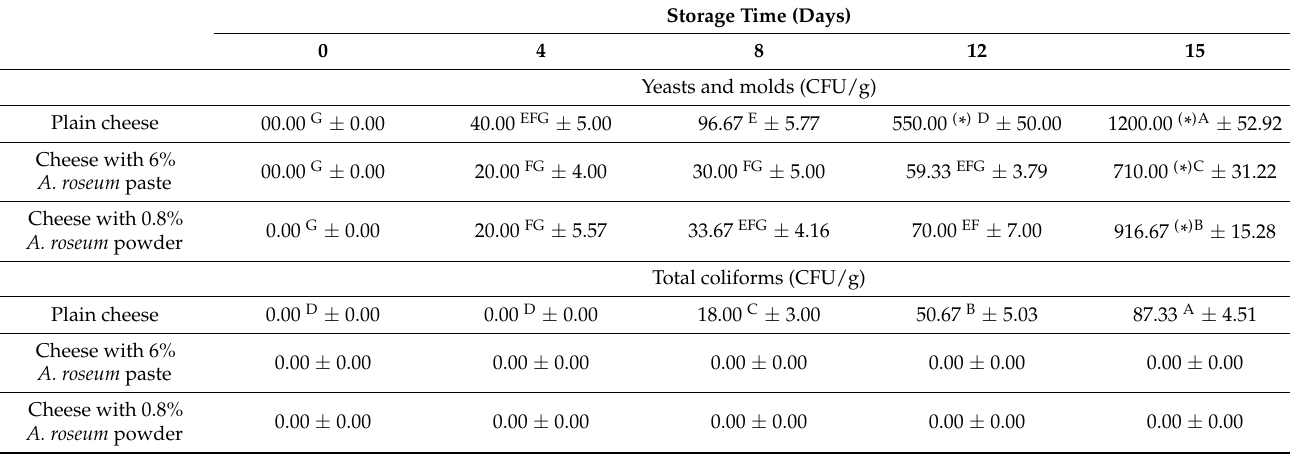
Table 3. Impact of Allium roseum supplementation on yeasts and molds, and total coliforms in double cream cheese during storage at 5 ◦